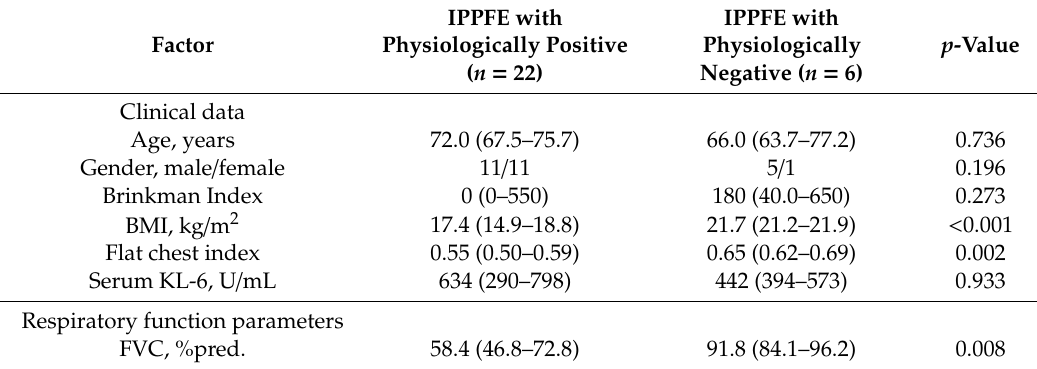
Table 3. The comparison of the clinical characteristics between IPPFE patients who met the physiological criteria at the time of the diagnosis and those who did not.